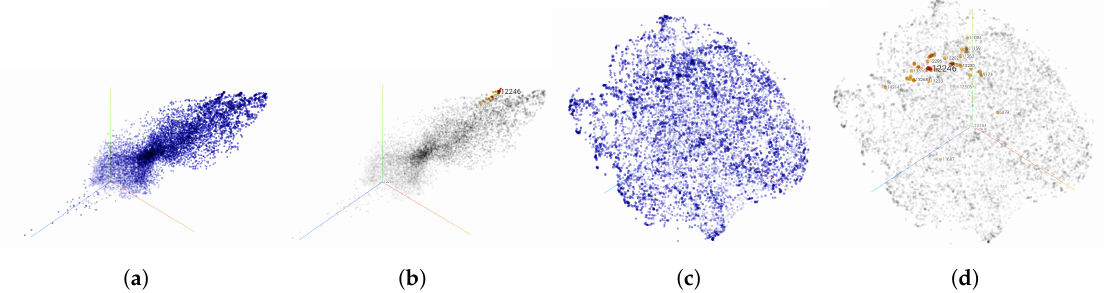
Figure 14. Different states in simulation (Figure 14a,c in training, and Figure 14b,d in testing) using a t-SNE projector. ( a ) Last iterations. ( b ) Last iterations. ( c ) Final stage. ( d ) Final